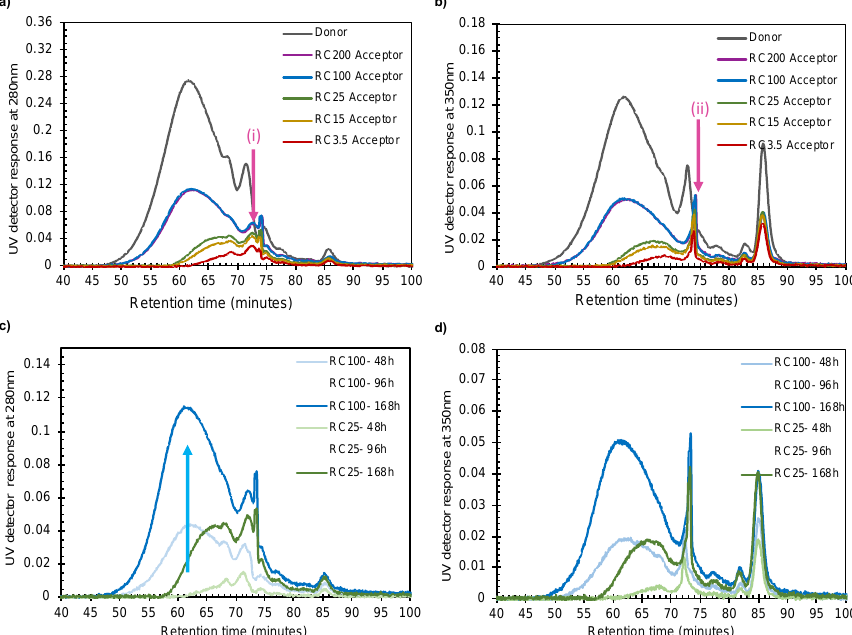
Figure 2. UV detector response of SEC versus retention time at ( a ) 280 nm and ( b ) 350 nm. Changes in UV detector response at ( c ) 280 nm and ( d ) 350 nm for three diffusion times with RC100 and RC25 membranes. (i) Refers to the peak at 72 min of the 280 nm chromatogram, which is missing in the 350 nm chromatogram. (ii) Refers to peak at 73 min, which is larger relative to the earlier peaks in the 350 nm chromatogram but not as large when compared to the earlier